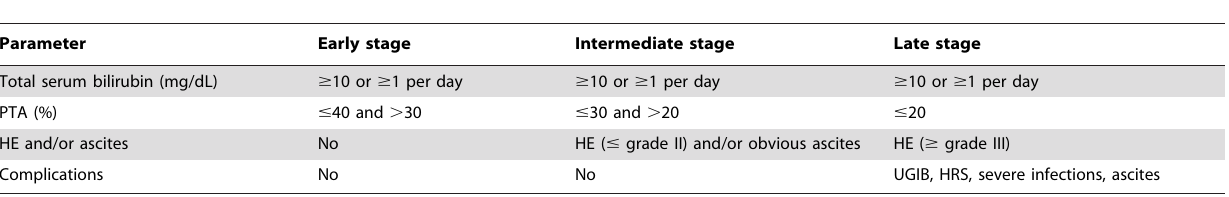
Table 1. Chinese staging criteria for acute-to-chronic liver